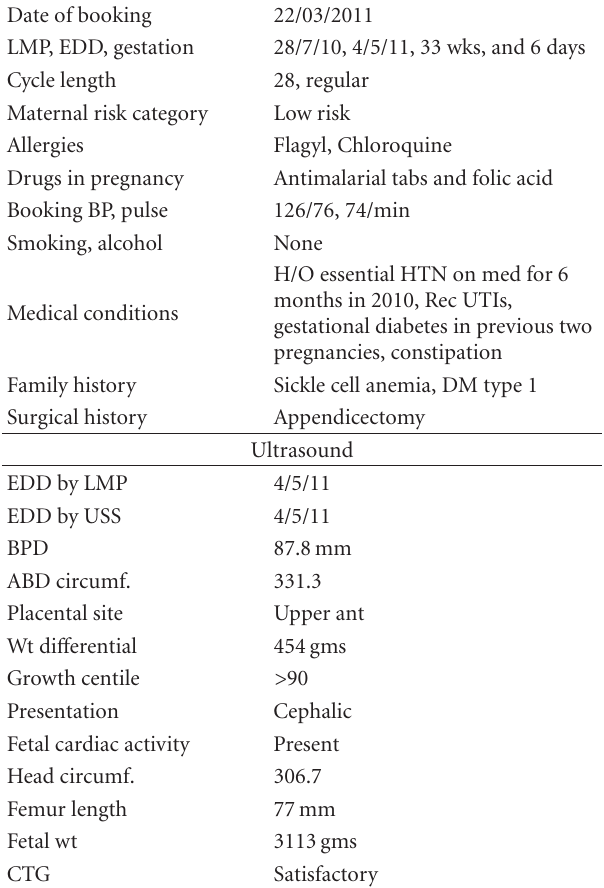
Table 1: Antenatal history.